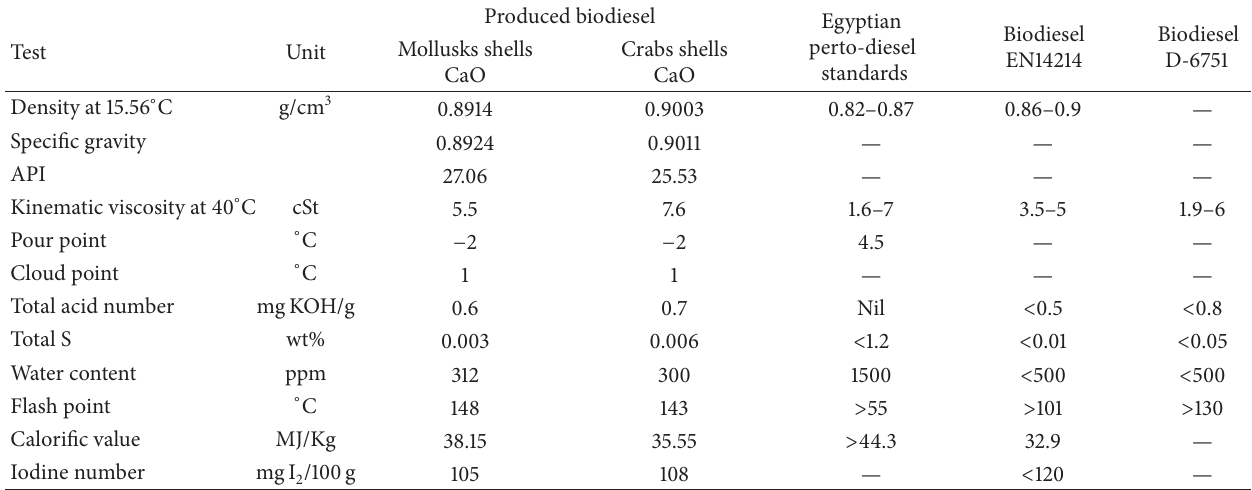
Table 6: Physicochemical properties of the produced biodiesel using CaO prepared from waste MS and CS compared to international standards of biodiesel and Egyptian petro-diesel standard